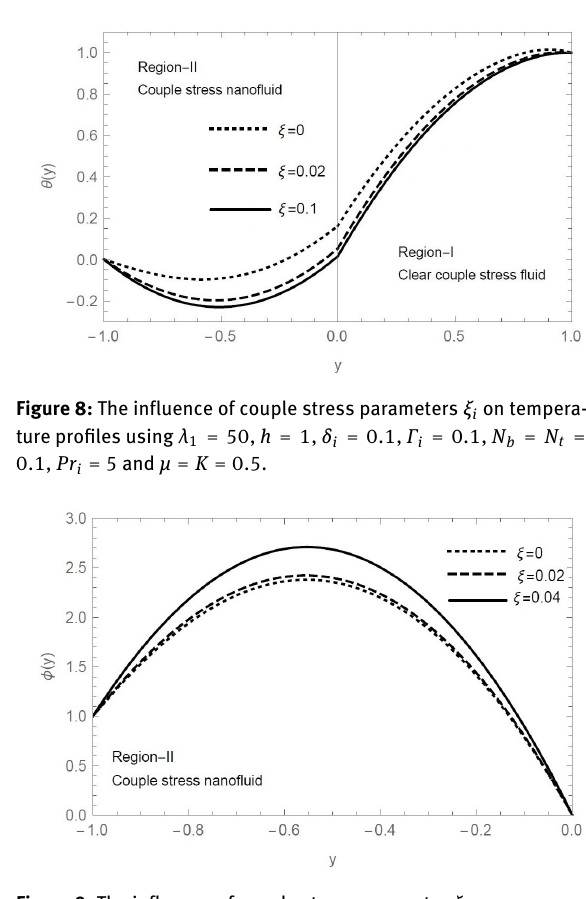
Figure 9: The influence of couple stress parameter ξ 2 on concen- tration profiles using λ 1 = 50, h = 1, Γ i = δ i = 0.1, N b = N t = 0.1, Pr i = 3 and µ = K = 0.5